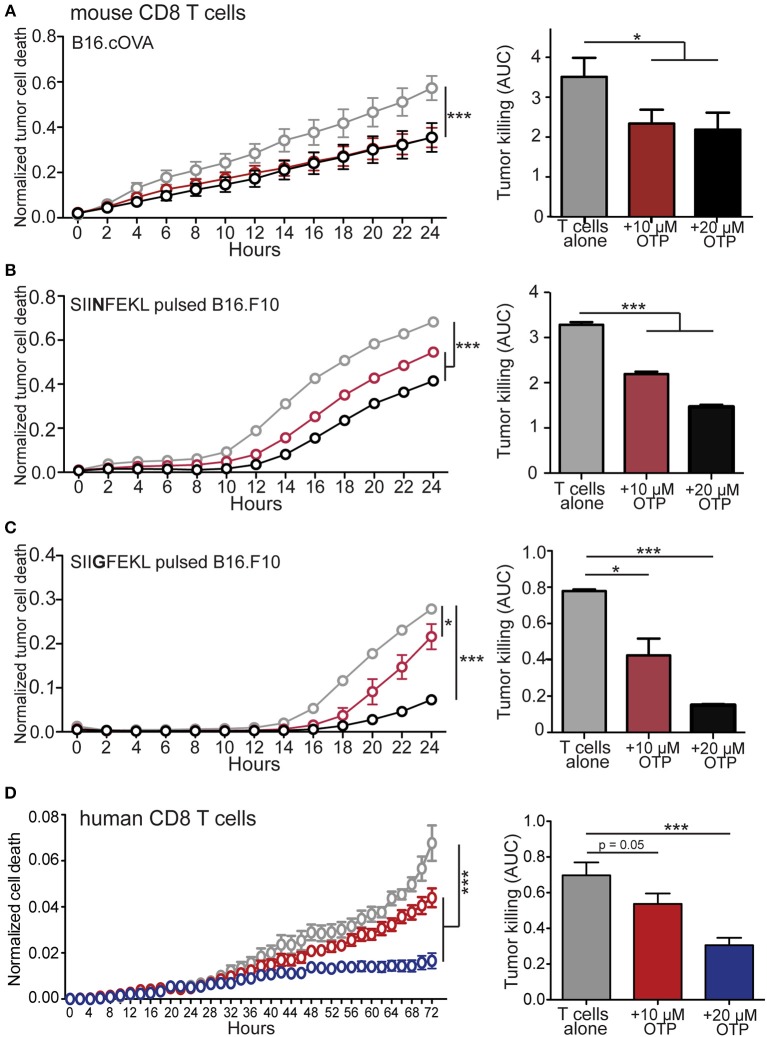
LPA inhibits in vitro murine and human CD8 T cell cytotoxic function. (A) Antigen activated effector OT-I CD8 T cells were added to RFP+ B16.cOVA cells together with a cell-permeable green fluorescent caspase-3/7 substrate and apoptotic (green+) RFP+ tumor cell cytotoxicity measured over time in the absence (gray) or presence of 10 μM (red) or 20 μM (black) OTP. Bar graphs quantify total B16.cOVA cell death over the 24 h period as area under the curve (AUC). ***p < 0.005 using two-way ANOVA or *p < 0.05 using Student's t-test. In B,C parental B16.F10.RFP tumor cells (not expressing cOVA) were plated and treated with 2 μg/mL of either (B) SIINFEKL high affinity peptide or (C) SIIGFEKL low affinity peptide for 24 h prior to the addition of activated OT-I T cells and tumor cell killing measured over 24 h. *p < 0.05; ***p < 0.0005 using a one-tailed paired Student's t-test or two-way ANOVA. Data are representative of 3 independent experiments with 3 technical replicates per group. (D) CD8 T cells enriched from PBMCs isolated from a health donor were added to SUM159.RFP tumor cells and RFP+ tumor cell killing monitored over time in the absence (gray) or presence of 10 μM OTP (red), or 20 μM OTP (blue). ***p < 0.005 using two-way ANOVA. Area under the curve is calculated for media only, media + 10 μM OTP, and media + 20 μM OTP. Data is accumulation of 4 different donors with 4 captured images per well and 3 technical triplicates per condition. ***p < 0.0005 by Student's t-test.